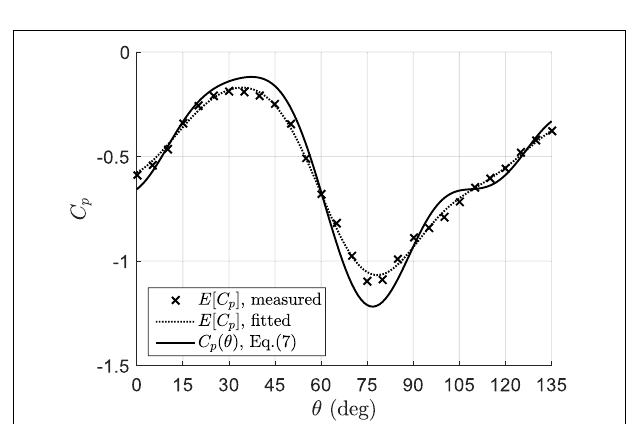
i.e., (cid:0) 50° (cid:20) Δβ < (cid:0) 2.5°, (cid:0) 2.5° (cid:20) Δβ < 2.5°, and 2.5° (cid:20) Δβ <